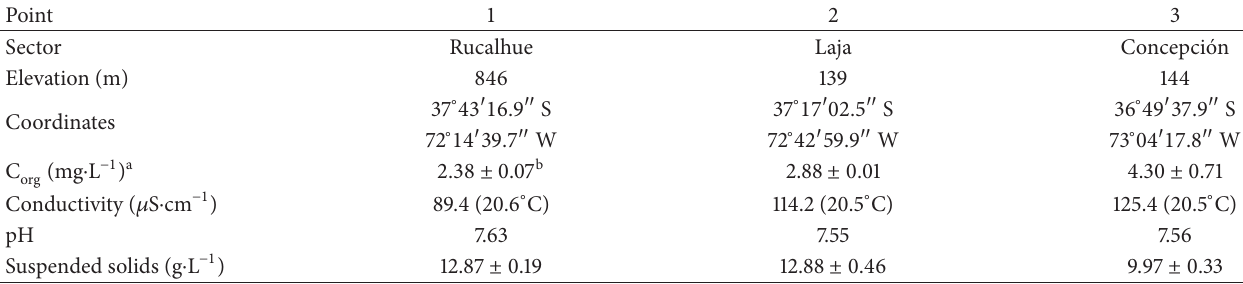
Table 1: Characterization of surface waters of the Bio-Bio River, VIII Region,